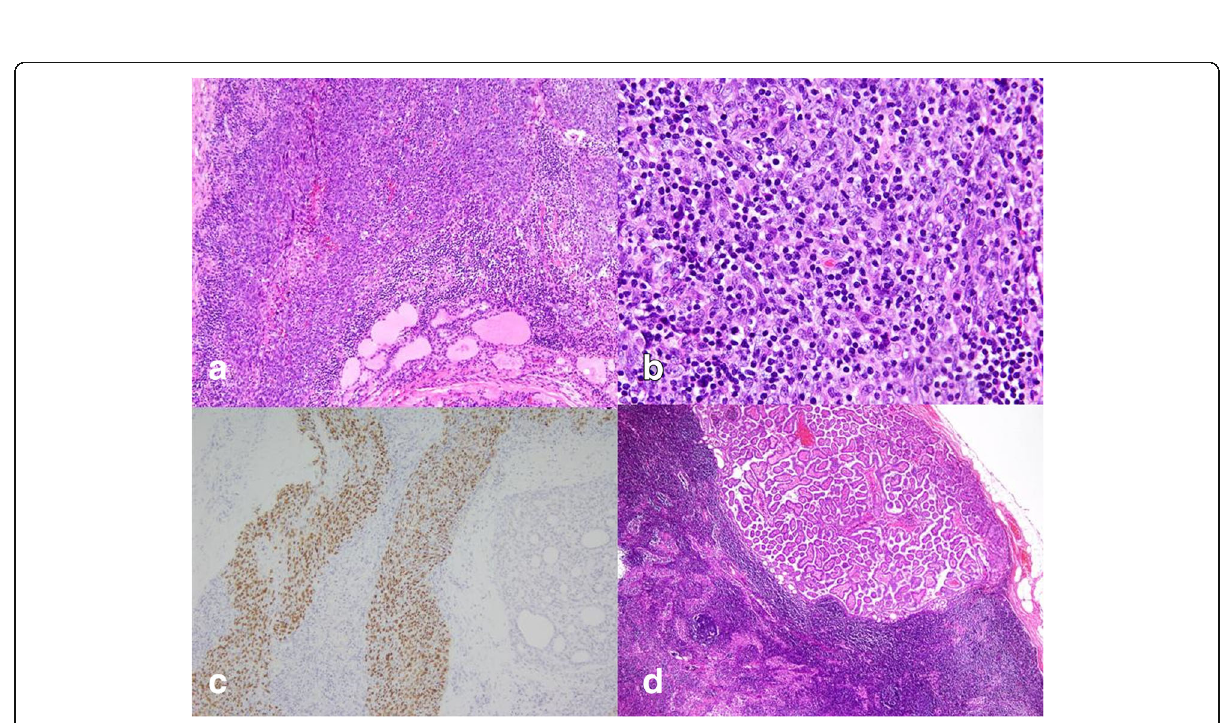
Fig. 3 Histopathological findings of left thyroid tumor: sheets or nests of epithelial cells infiltrated by lymphoplasmacytic cells ( a . H&E, 100X; b . H&E, 200×); malignant epithelial cells positive for EBER ISH ( c . Hematoxylin counterstain, 200×); metastatic papillary carcinoma found in right neck lymph node ( d . H&E,